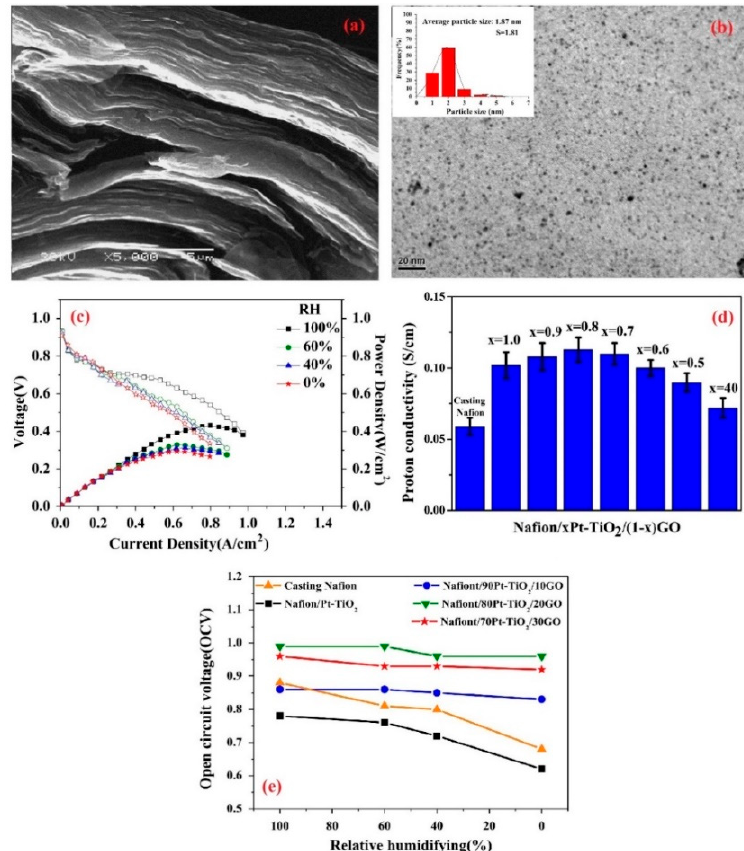
Figure 8. ( a ) SEM image of graphene oxide (GO) sheets (reprinted with permission from [95]); ( b ) TEM illustration of Pt–graphene with average Pt particle size of 1.87 nm and ( c ) I-V curves for 1.5 wt % Pt–G and 1.5 wt % SiO 2 additives in a Nafion nanocomposite membrane at 80 °C and different relative humidity (RH) values (reprinted with permission from [96]); ( d ) proton conductivity and ( e ) open circuit voltage (OCV) values for plain and nanocomposite PEMs containing Pt–TiO 2 and GO additives (reprinted with permission from [97]).